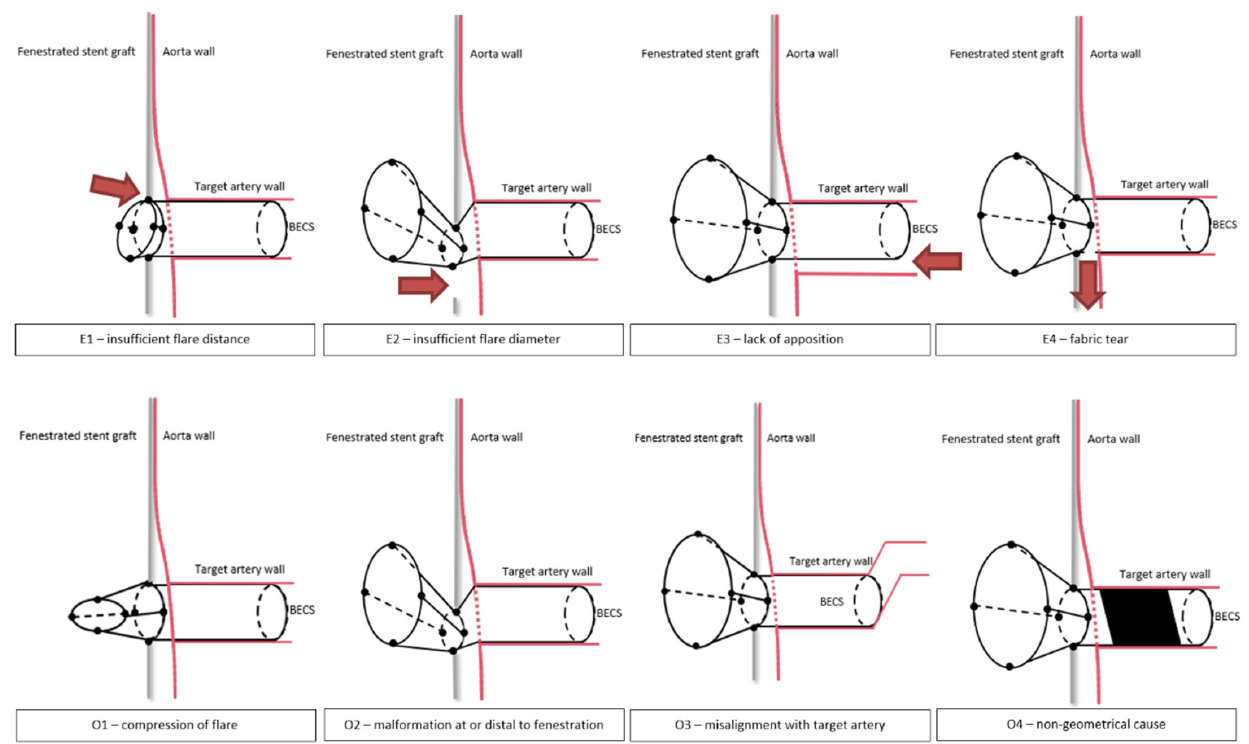
Figure 2. Schematic representation of modes of balloon ‐ expandable covered stent (BECS) failure for endoleak and obstruction. The red arrows represent the blood flow in case of an endoleak.